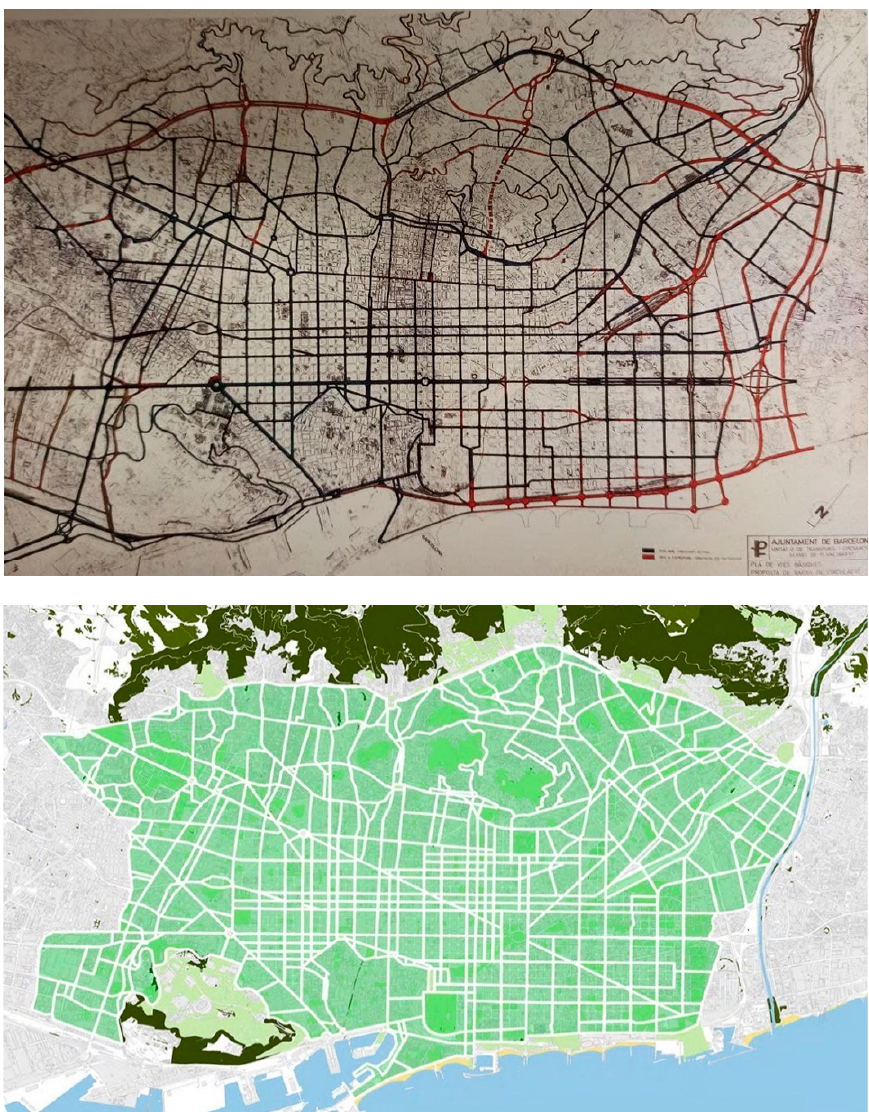
Figure 4. ( Top ) The 1984 Road Plan. Source: Ajuntament de Barcelona [64]; ( Bottom ) Superblocks Plan of 2002 (green areas delimited by white lines) included in the Urban Mobility Plan (2013–2018) Source: Ajuntament de Barcelona [49].